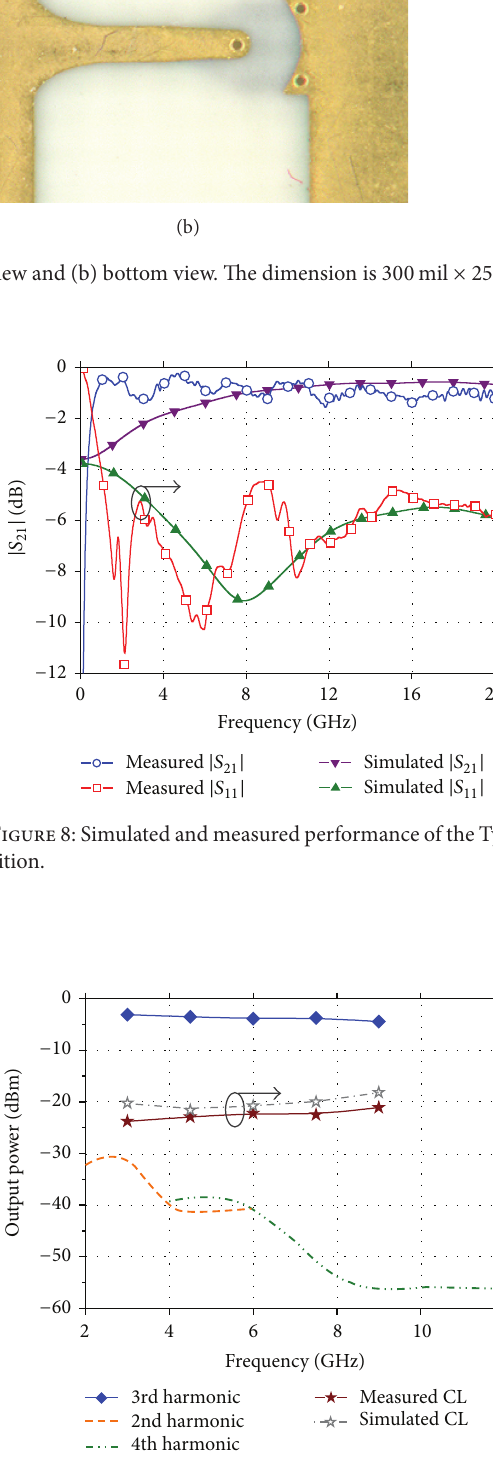
Figure 9: Simulated and measured results of conversion loss and measured results of output powers with respect to output frequency (Type A